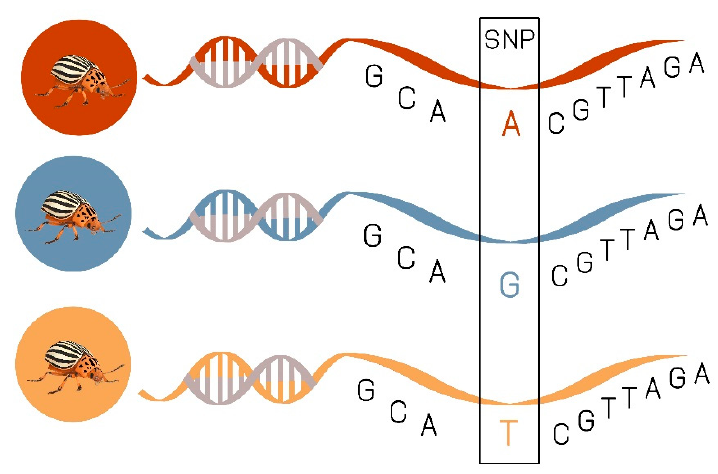
Figure 5. Example for single nucleotide polymorphisms (SNPs), single changes in the genetic code.